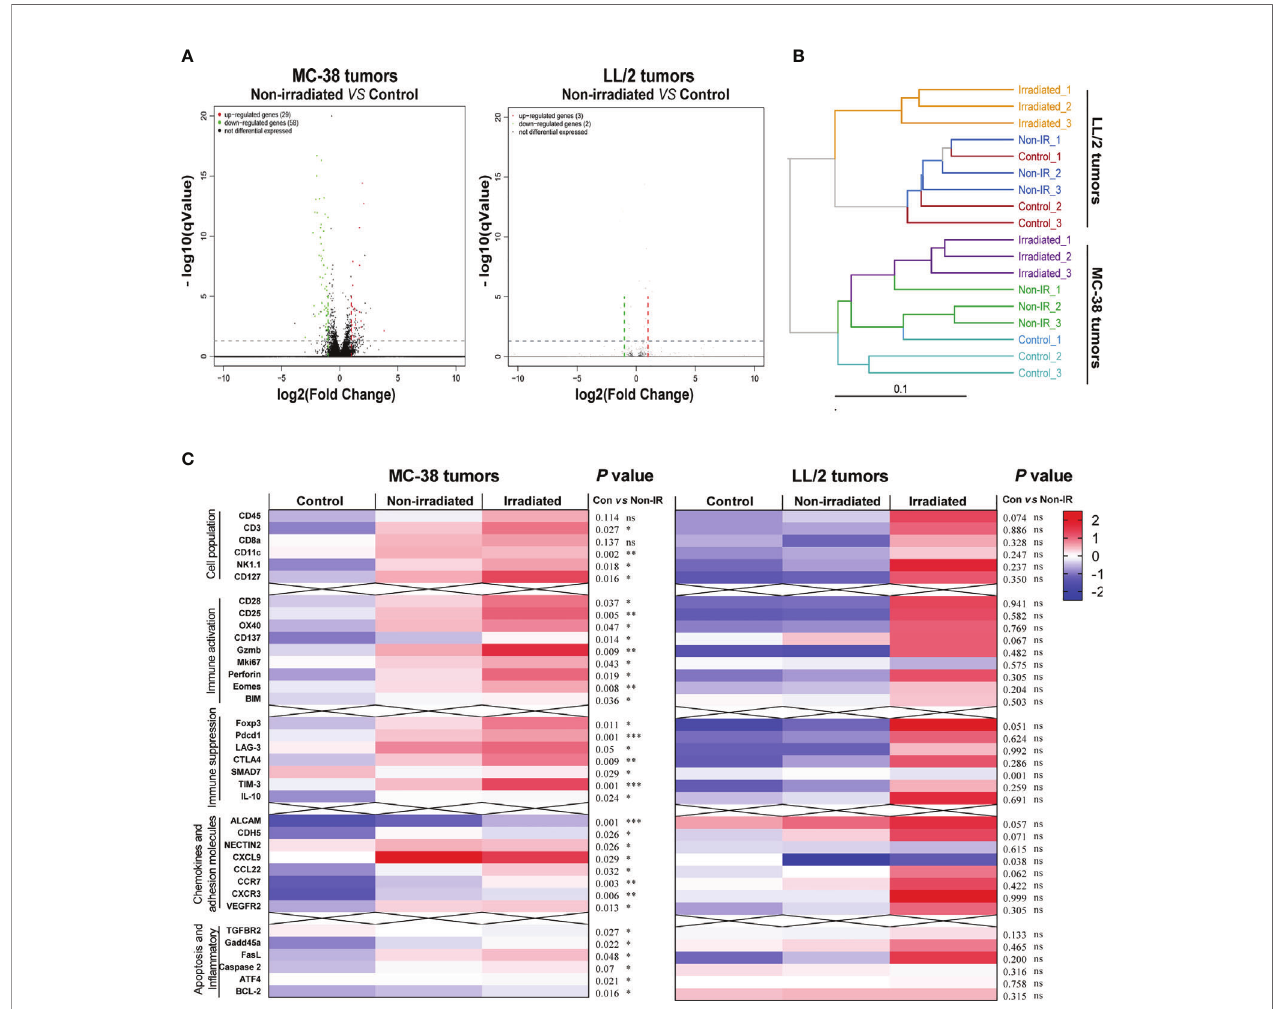
FIGURE 4 | Differentially expressed genes of irradiated tumors, non-irradiated tumors and sham-radiated tumors in the MC-38 and LL/2 tumors. (A) Volcano plots for gene expression of non-irradiated tumors and sham-radiated tumors in the MC-38 and LL/2 tumor models. The red and green dots represent up- and downregulated DEGs (differentially expressed genes), respectively. (B) Cluster tree showing the dissimilarity and relevance within the irradiated tumors, non-irradiated tumors and sham-radiated tumors in the MC-38 and LL/2 tumors. (C) Heat map of immune-related gene expression in the MC-38 tumors and LL/2 tumors 8 days after radiation, including markers of immune cell populations and genes involved in immune activation, immune suppression, cell adhesion and in fl ammation (n = 3). To compare the immune-related gene expression levels between the non-irradiated tumors and sham-radiated tumors, RNA-seq data were normalised and analysed by the Mann – Whitney test. * p < 0.05, ** p < 0.01,*** p < 0.001, ns, no signi fi